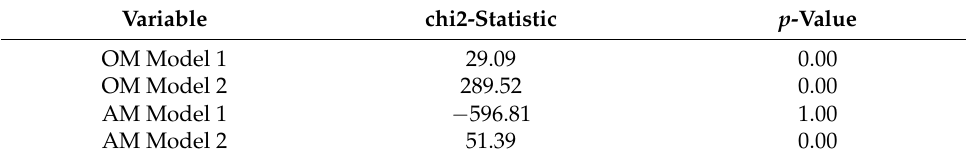
Table A8. Hausman test for panel data.